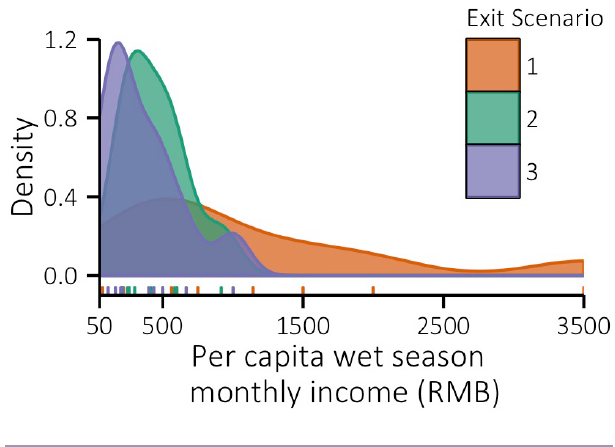
Fig. 3 . The distribution of per capita monthly incomes associated with those respondents that would exit early (1; after the extirpation of large mammals), midway (2; after the extirpation of large birds), or late (3; after the extirpation of small birds, or refusal to exit in all conditions). The tick marks below the density plots show the individual responses observed for each exit threshold. Respondents who would exit late (that is, they expressed willingness to continue hunting when the prey base solely comprised small passerines and expected catch was low) had lower incomes on average than early exiters.